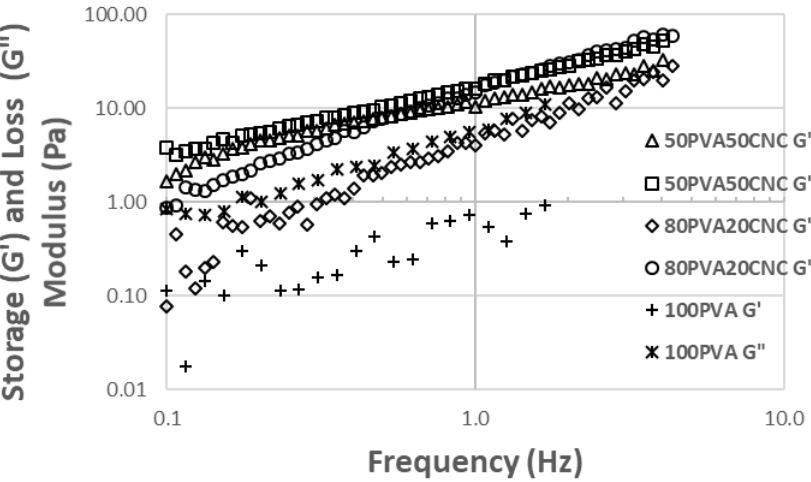
Figure 4. Data measured from a frequency (Hz) sweep (0.1–10) of aqueous suspension neat PVA and PVA / CNC at varying weight percentages. Some data was omitted because the phase angle was too large.